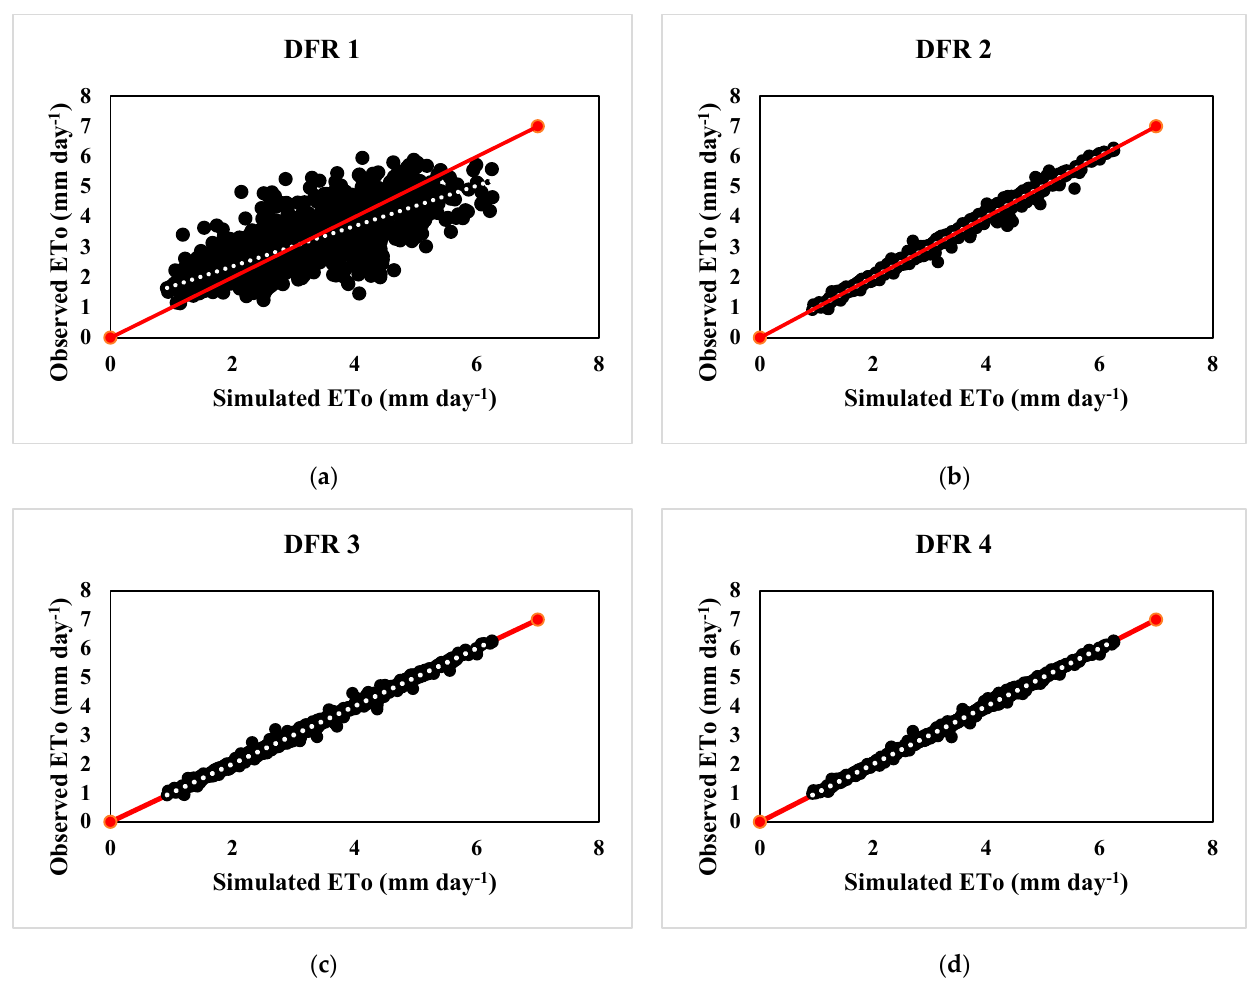
Figure 3. Comparison of the daily observed and simulated ET 0 by DFR model; ( a ) DFR 1; ( b ) DFR 2; ( c ) DFR 3; ( d ) DFR 4 (Cameron Highlands station).